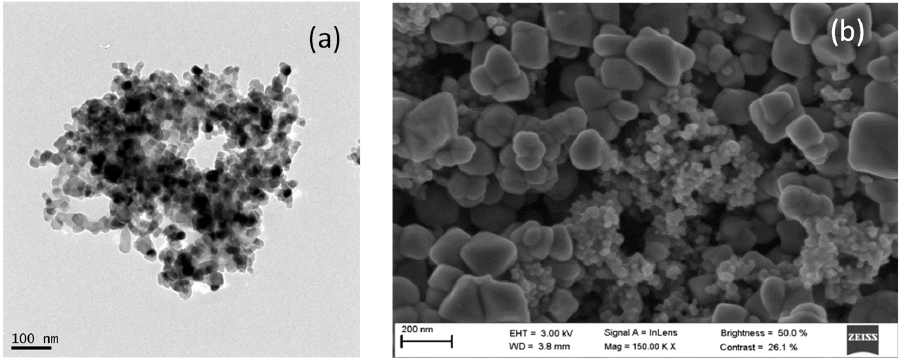
Figure 5. TiO 2 @Fe 3 O 4 nanocomposite: ( a ) TEM image, ( b ) SEM image .